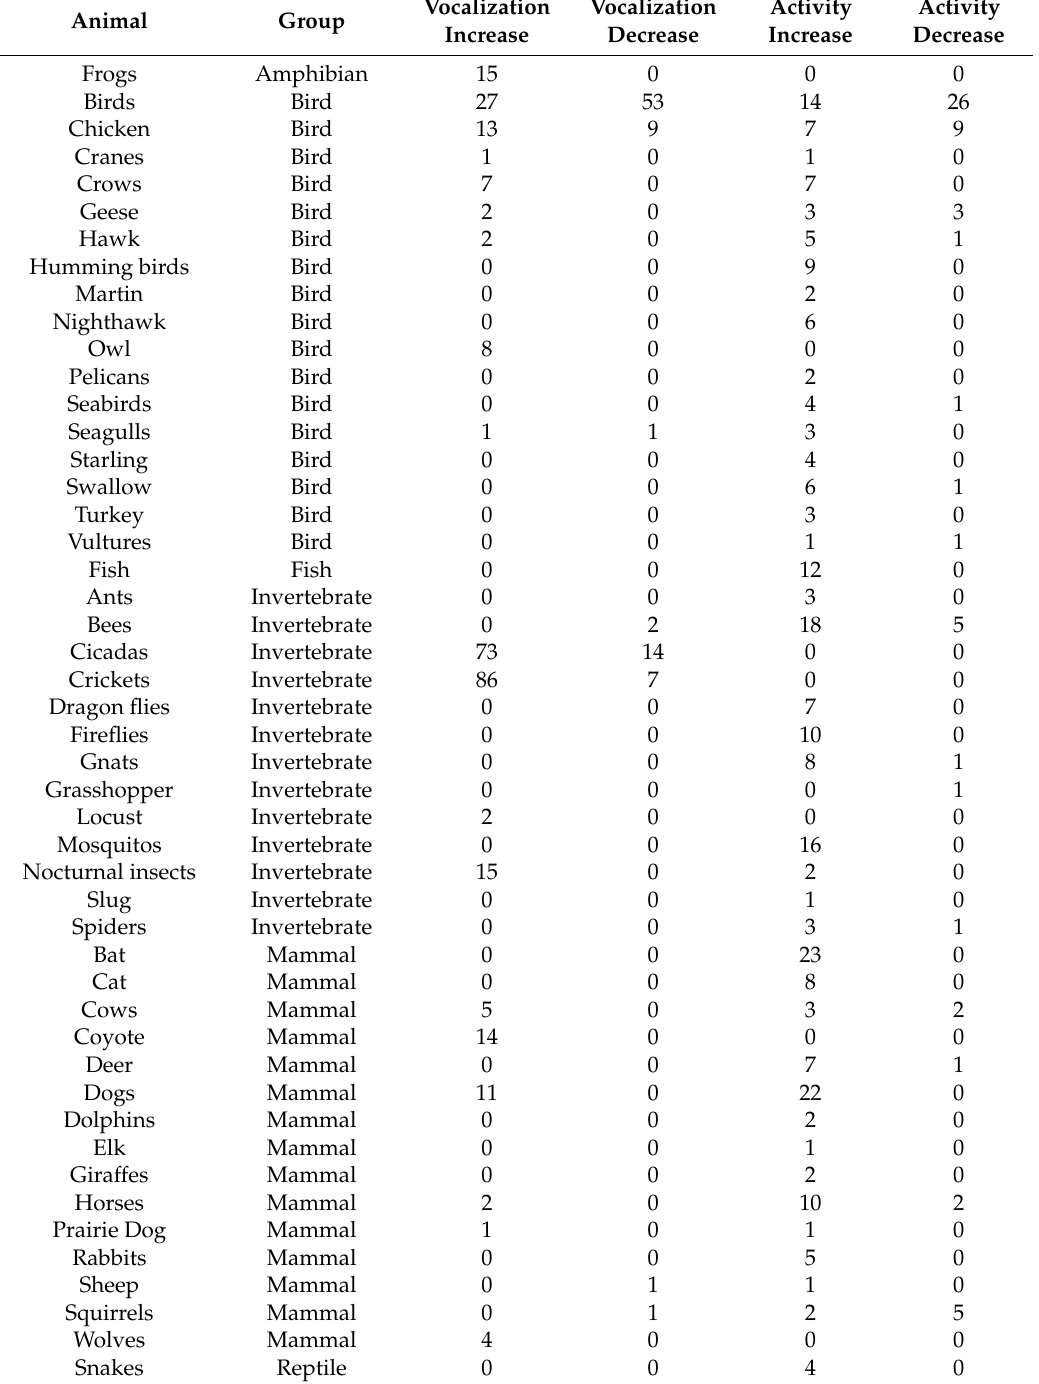
Table 1. Total number of animal behavior observations enumerated from March for Science Facebook discussion during 2017 Great American Solar